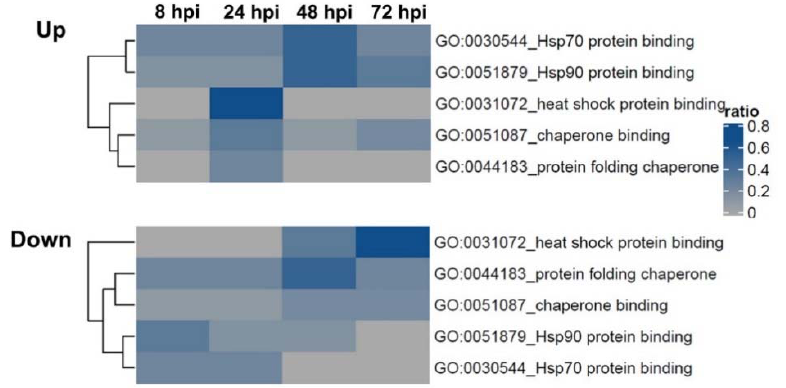
Figure 6. Hierarchical clustering of the proportion of DEPs among proteins annotated with each heat shock-related and chaperone function. Euclidean metric and complete linkage were used.